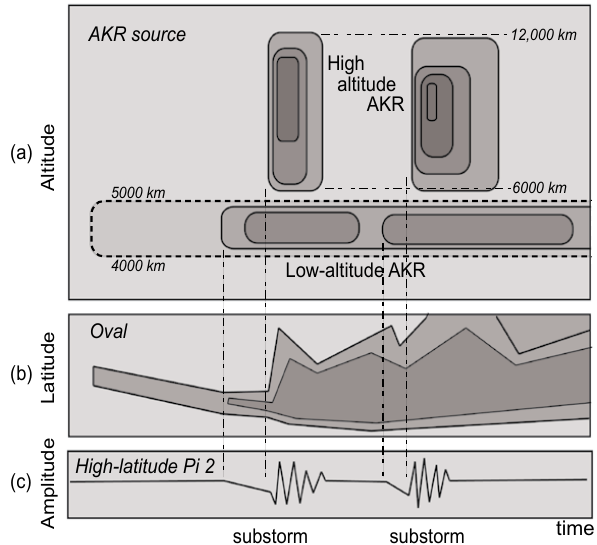
Schematic illustration of substorm-time evolution of (a) AKR source, (b) auroral oval, and (c) high-latitude Pi2 pulsa-